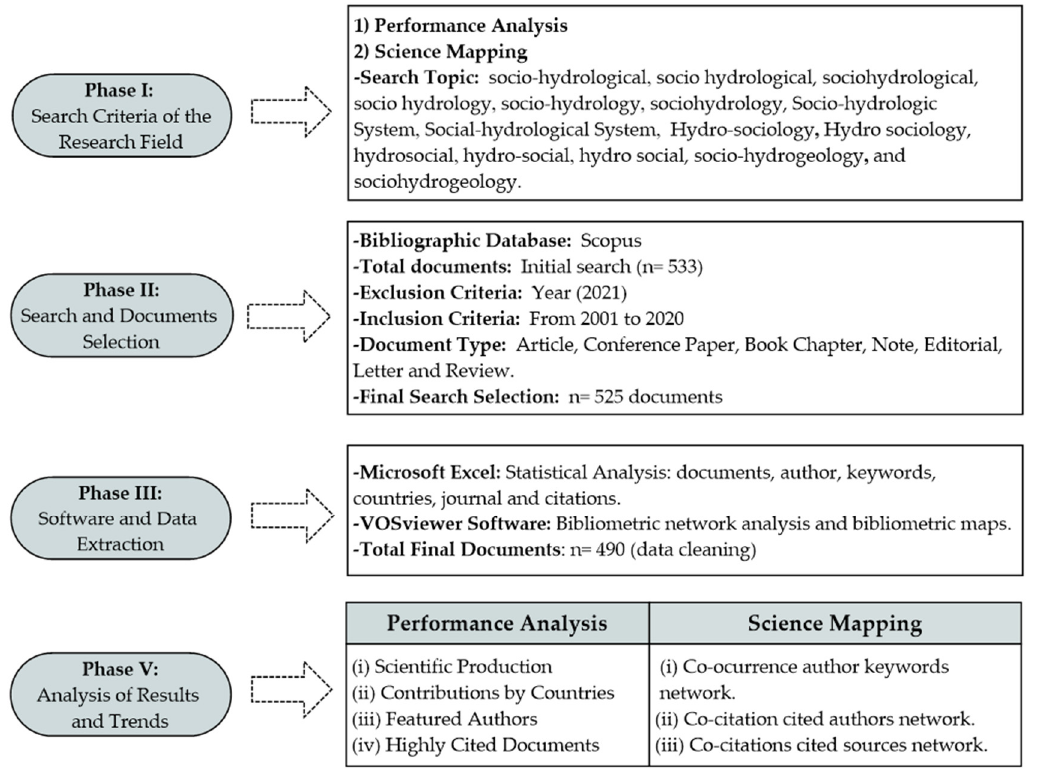
Figure 3. Methodological scheme of the process carried out in this study.